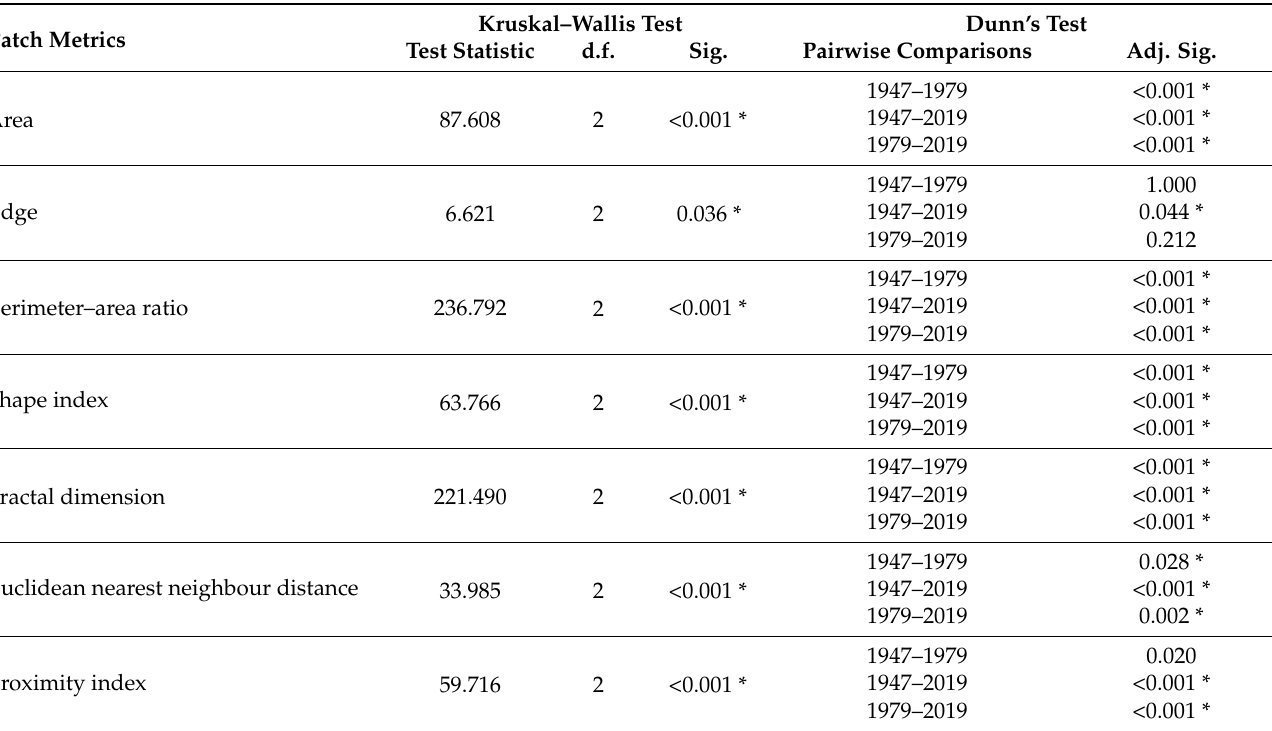
Table 5. Outputs of the Kruskal–Wallis test (and post hoc pairwise comparisons) on patch metrics, considering the analysis for the HER class (N = 1564; significance values for Dunn’s test were adjusted by the Bonferroni correction for multiple tests).